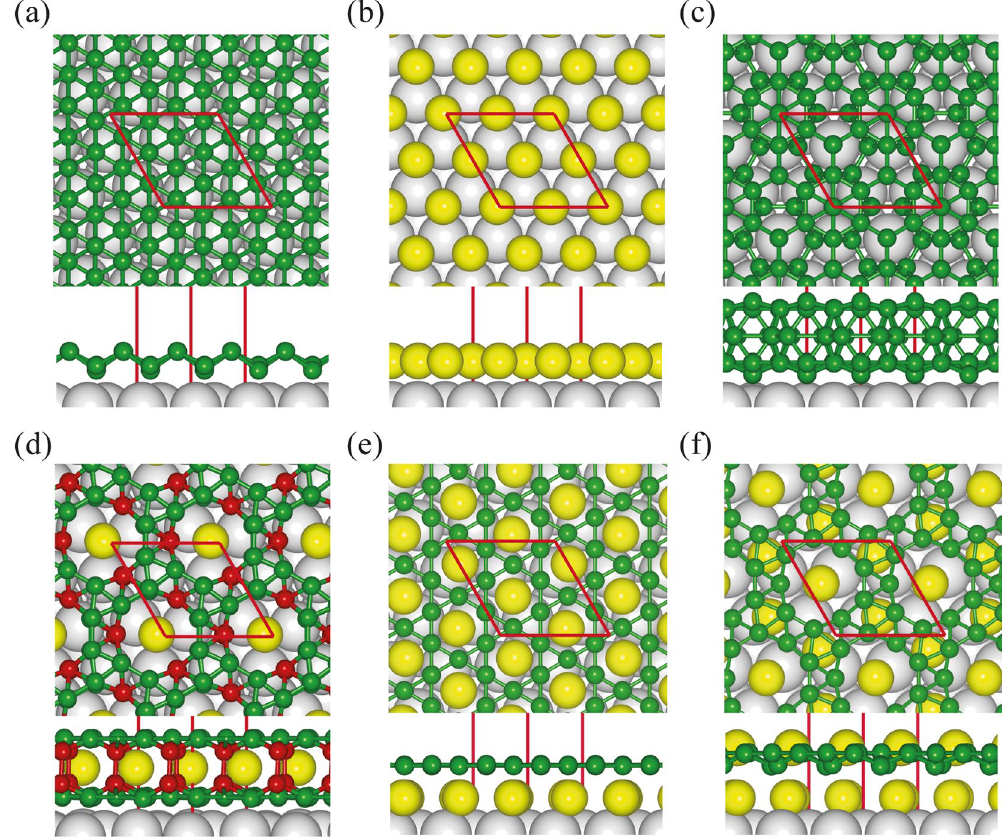
Figure 2. Atomic structures of B-Mg systems on Ag(111). The atomic structures of ( a ) Mg 0 B 12 (referred to as borophene), ( b ) Mg 4 B 0 , ( c ) Mg 0 B 24 , and ( d ) Mg 1 B 18 are drawn. The Mg 0 B 24 structure consists of B 20 rectified hexagonal bipyramids connected by four B atoms. The atomic structures of Mg 3 B 9 are shown for ( e ) the metastable and ( f ) most stable configurations. Yellow, green, and gray balls represent the Mg, B, and Ag atoms, respectively. Red rhombuses represent the 2 × 2 supercell on the Ag(111)